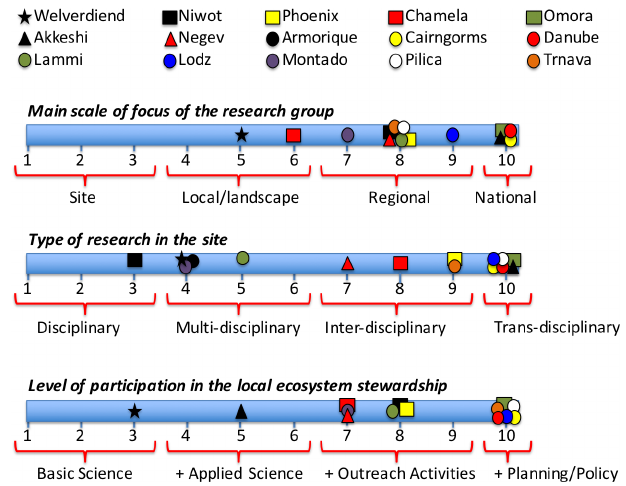
Fig. 4 . Research activity of the 15 ILTER case-studies identified as potential participants in a ILTER/PECS